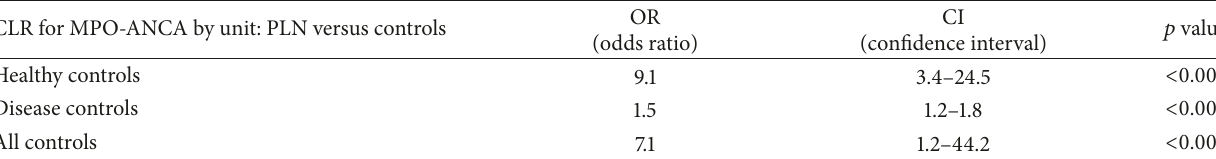
Table 3: Conditional logistic regression (CLR) for PLN MPO-ANCA by unit versus healthy controls, SLE without LN disease controls, and all controls together.